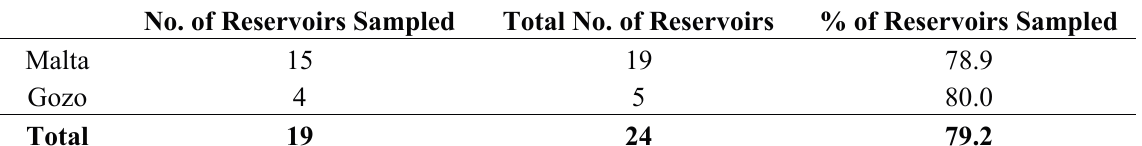
Table 1. Percentage of reservoirs sampled from the whole